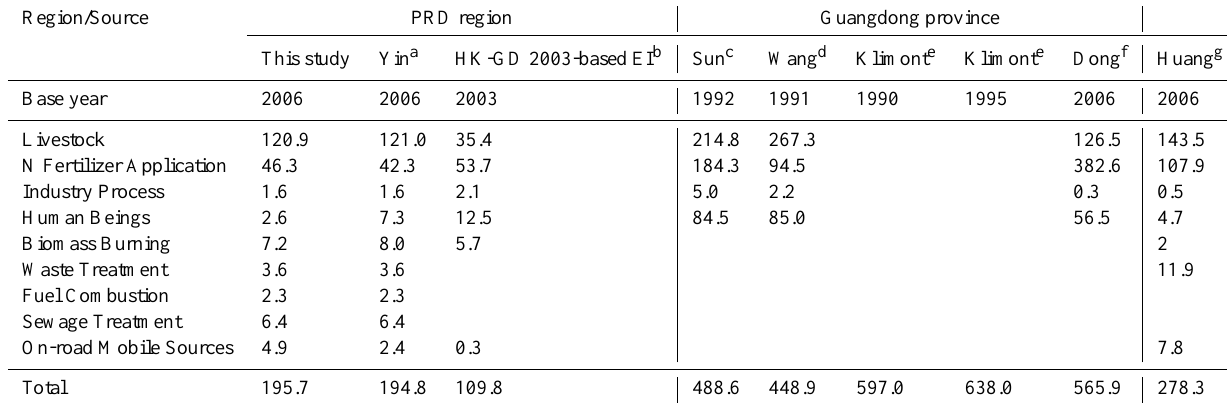
Table 5. Comparison with other studies.